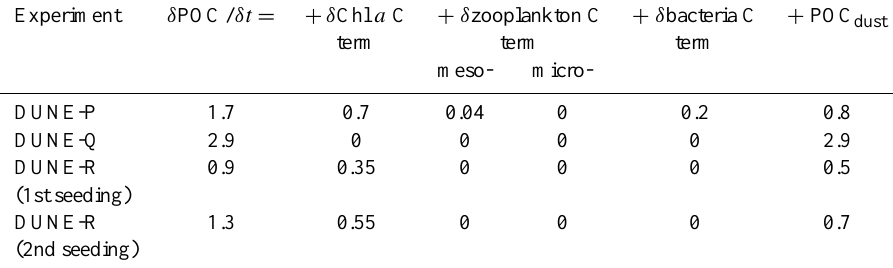
Table 2b. Estimated induced changes in the particulate organic carbon pool inside the DUST mesocosms (see Sect. 2.4 for details).